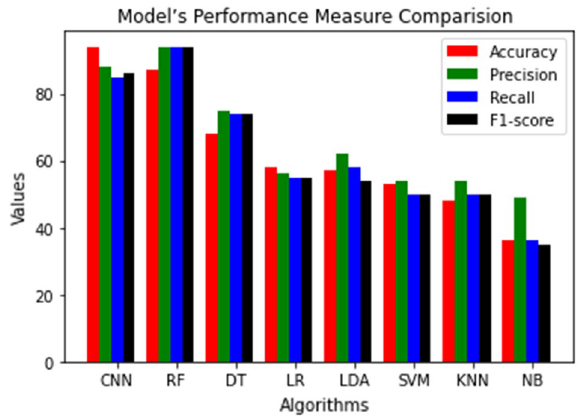
Figure 6. Model’s performance measure comparison.